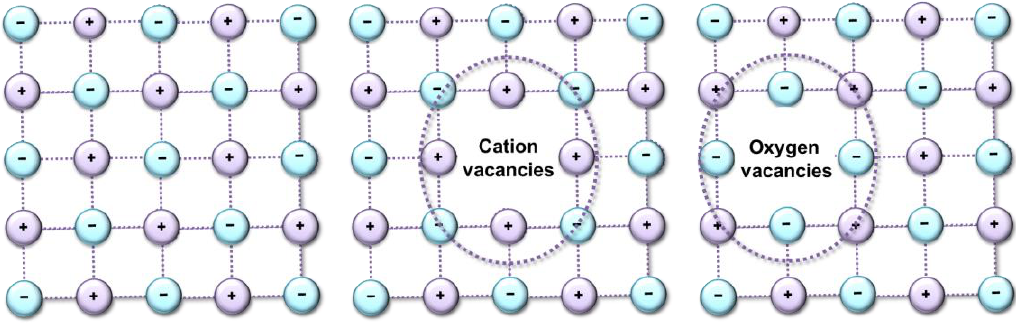
Figure 8. Scheme of formation of type of defects.